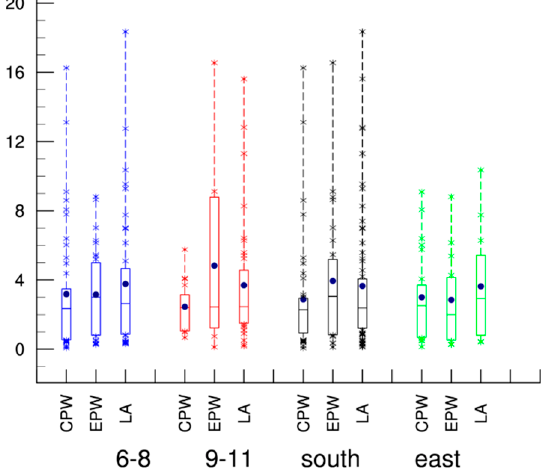
Figure 6. Same as in Figure 3, but for TC duration (h) after landfall. Atmosphere 2019 , 10 , x FOR PEER REVIEW